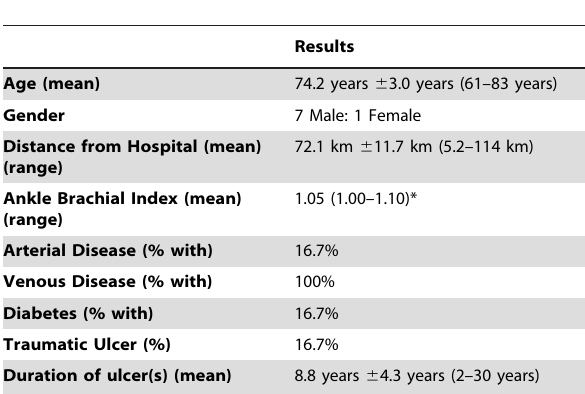
Table 1. Patient demographics and clinical data.